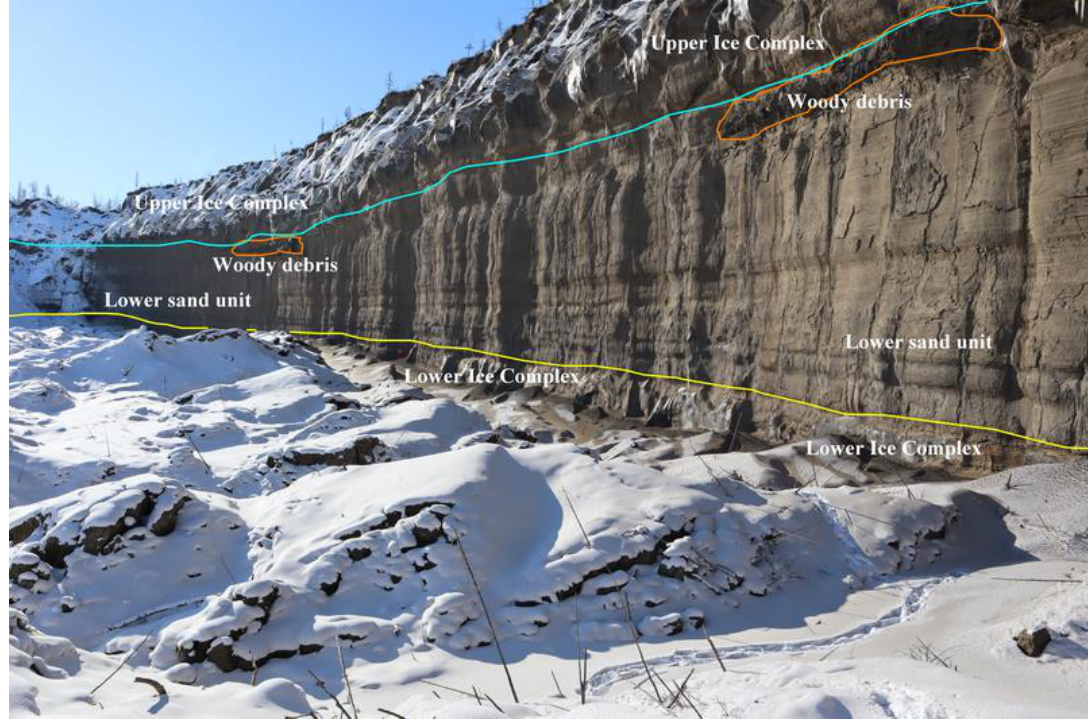
Figure 2. Outcrop in the form of a steep wall (southern exposure), represented by upper and lower Ice Complex units intersected by the lower sand unit and overlain by the shielding and active layers.